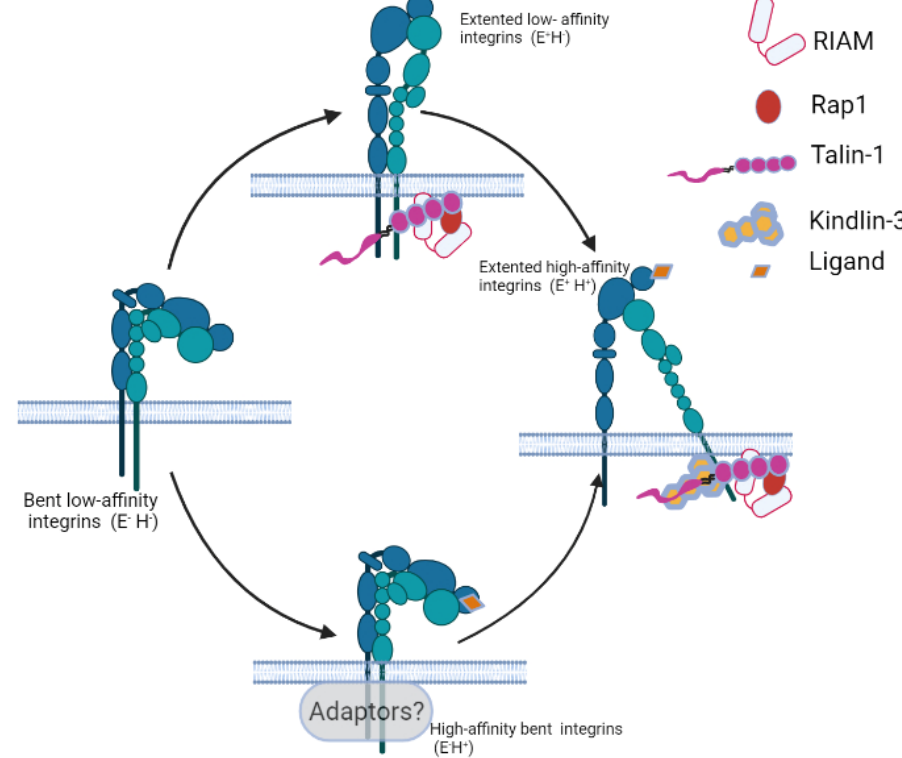
Figure 2. Schematic of the integrin activation conformational changes and key modulators: Resting integrins have a bent low-affinity (E − H − ) conformation. They attain an extended low-affinity (E + H − ) confirmation through the RIAM- and Rap1-mediated recruitment of talin-1. Further recruitment of kindlin-3 induces full integrin activation into extended high-affinity integrins (E + H + ). There is an alternative allosteric pathway in which E − H − integrins transition to a bent-high affinity conformation (E − H + ) and then change to an extended high-affinity integrin (E + H + ). Which integrin adaptors are involved in this allosteric pathway remains to be further investigated. Created in BioRender.com (accessed on 12 June